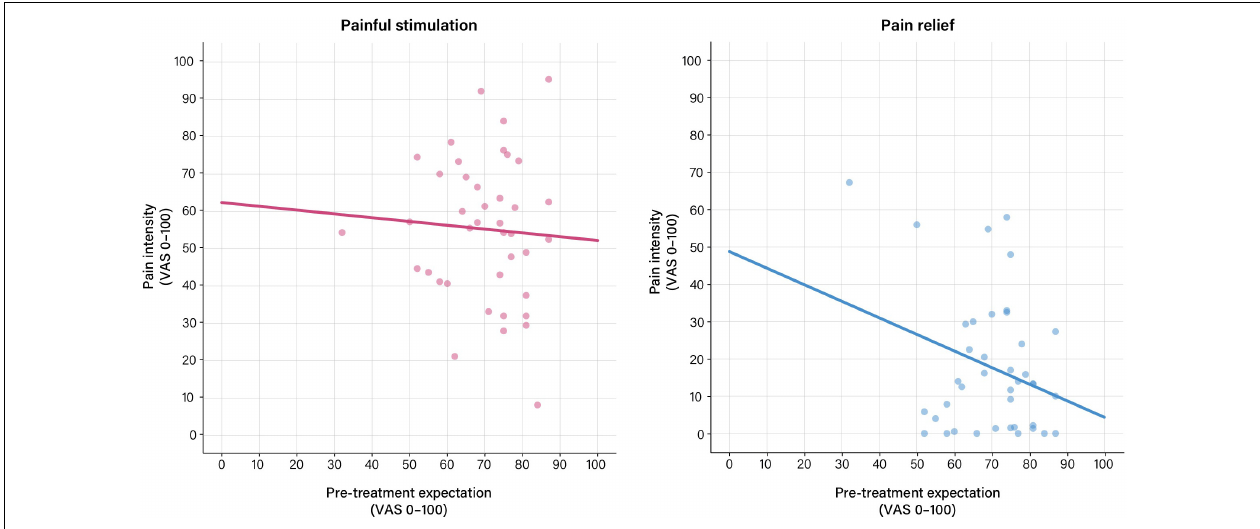
FIGURE 3 | Associations between pre-treatment expectation and perceived distension intensity based on general linear models (GLM) calculated using pre-treatment expectation as exploratory and perceived intensity ratings as response variables. (Left) For the pain phase, no significant association between pre-treatment expectation and perceived distension intensity was observed. (Right) For the relief phase, the association between pre-treatment expectation and perceived distension intensity approached significance ( b = 0.30, t = –1.97, p = 0.057). For details, see Table 3 . For results after exclusion of outliers, see Supplementary Table 4 and Supplementary Figure 2